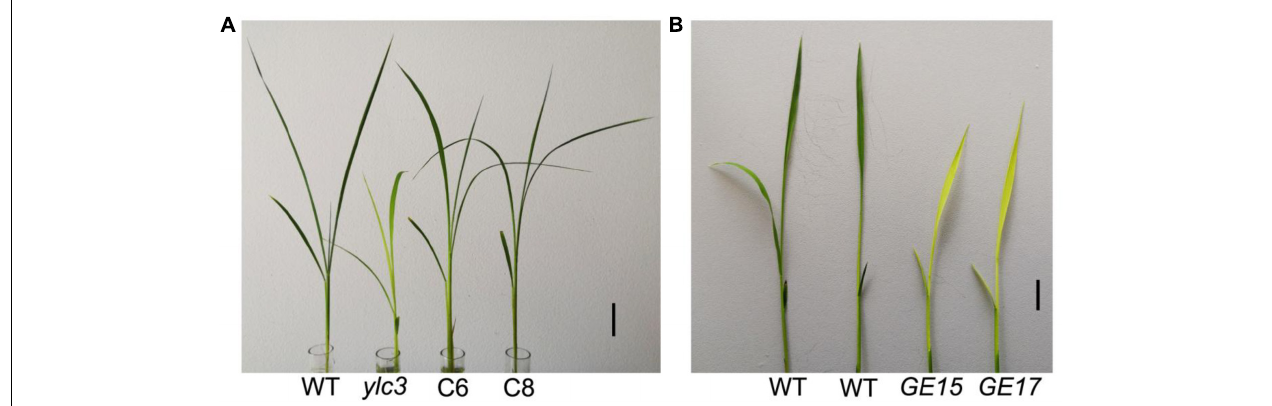
FIGURE 4 | Complementation and YLC3 gene editing analysis. (A) The ylc3 mutation was complemented by YLC3 promoter expression of a full-length YLC3 coding sequence. Bar = 3 cm. (B) YLC3 gene-editing transgenic seedlings showed the yellow leaf phenotype at low temperature. Bar = 1 cm.